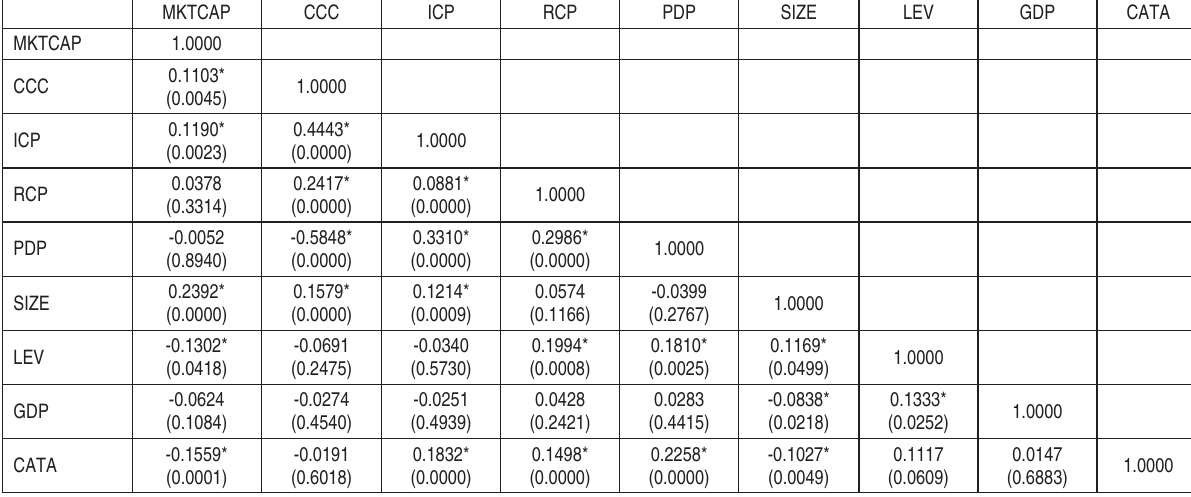
Table 4. Correlation matrix of firm value, WCM components and control